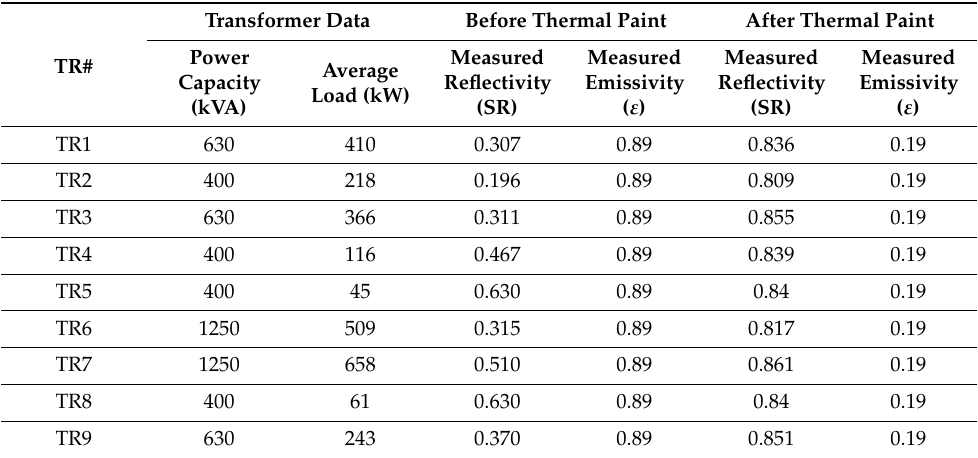
Table 1. Average load and power capacity of the transformers and the reflectivity / emissivity values before and after the thermal paint is applied to the surfaces of the transformer building.